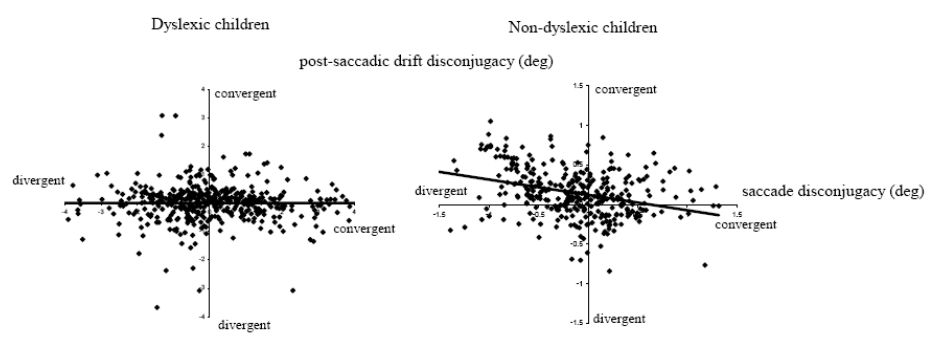
Figure 7. Relationship between saccade and drift disconjugacy. For each saccade in the reading task condition, the disconjugacy of the saccade is shown in degrees (X-axis) and the disconjugacy of the post-saccadic drift (Y-axis). Positive values indicate conver- gent disconjugacy, negative values divergent disconjugacy. Note the different scale for both diagrams .